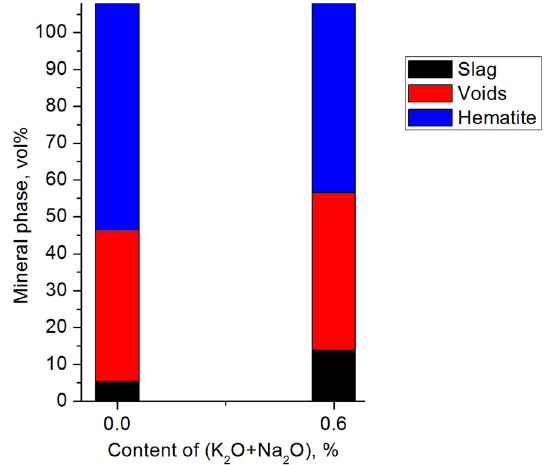
Figure 4: Phase analysis of roasted briquettes with varying ( K + Na ) . 2 O 2 O